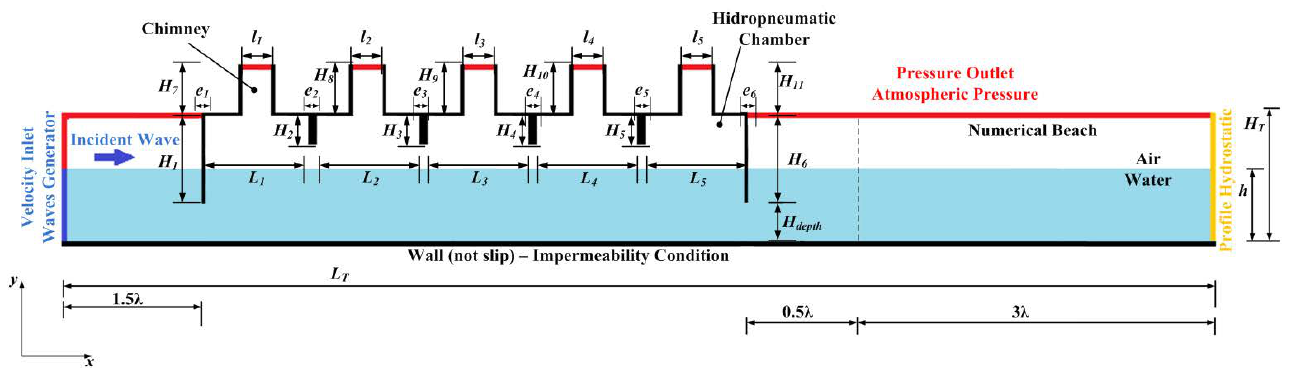
Figure 3. Boundary conditions and dimensions of the computational domain composed of the wave tank and the OWC device with five coupled chambers.